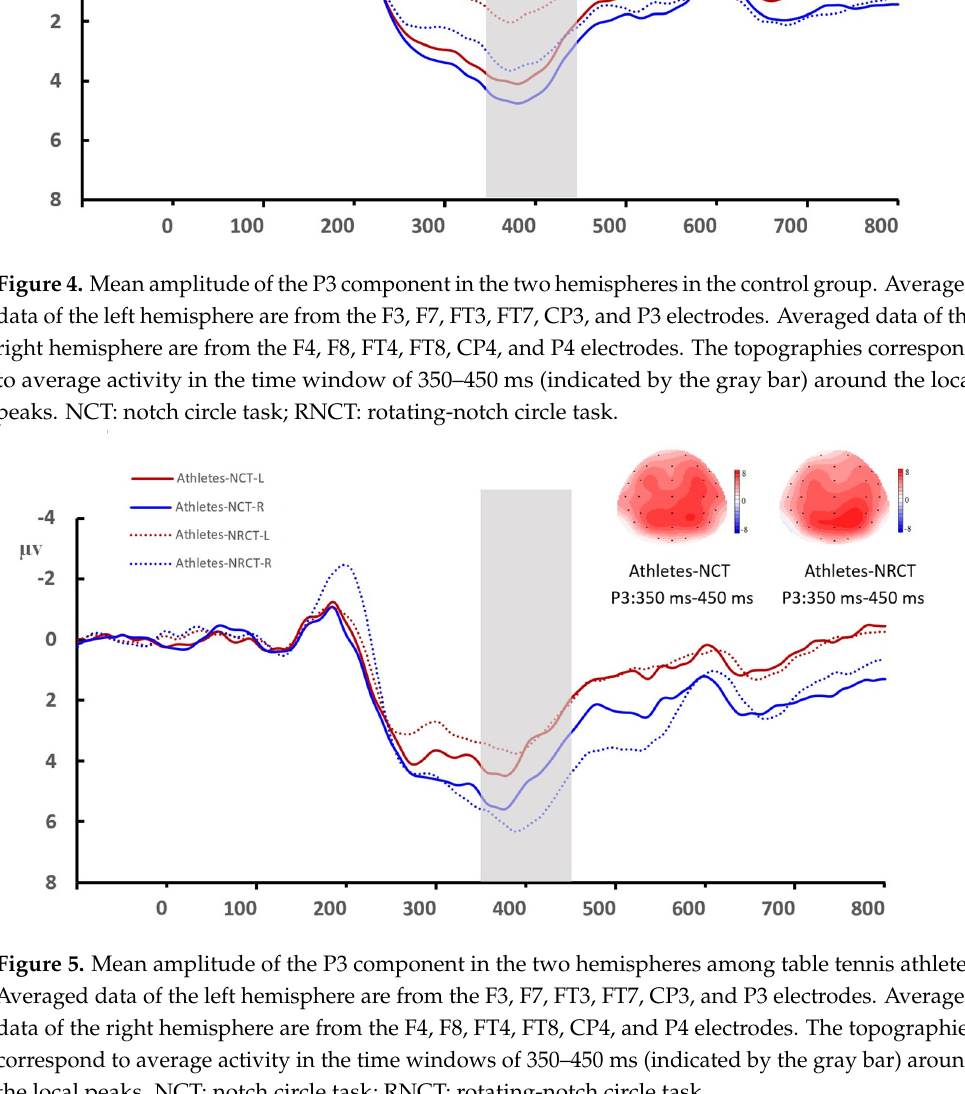
Figure 5. Mean amplitude of the P3 component in the two hemispheres among table tennis athletes. Averaged data of the left hemisphere are from the F3, F7, FT3, FT7, CP3, and P3 electrodes. Aver- aged data of the right hemisphere are from the F4, F8, FT4, FT8, CP4, and P4 electrodes. The topog- raphies correspond to average activity in the time windows of 350–450 ms (indicated by the gray bar) around the local peaks. NCT: notch circle task; RNCT: rotating-notch circle task.